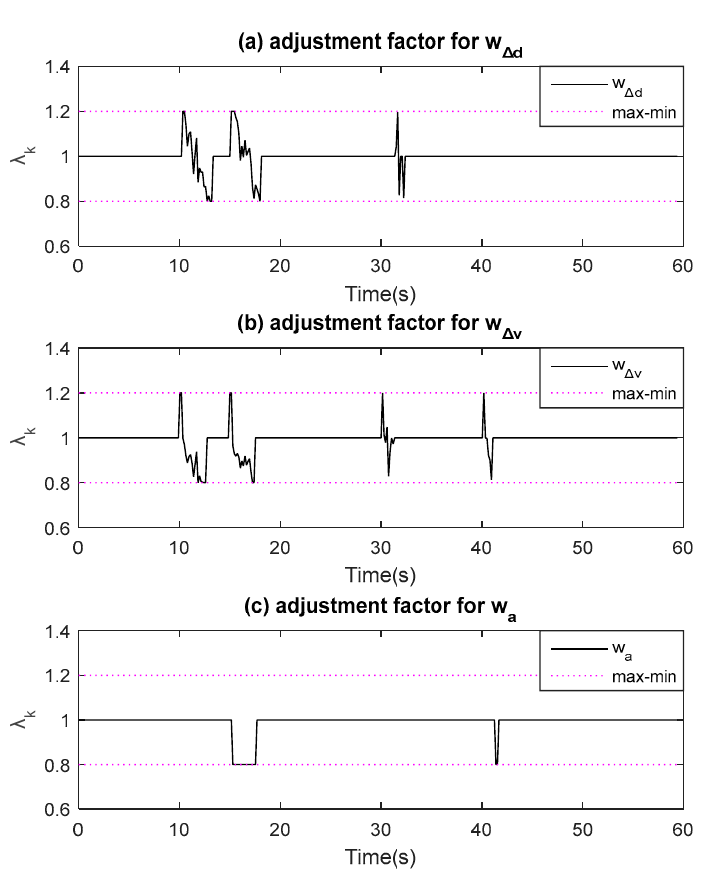
Figure 11. Adjustment factor for weight coefficient.